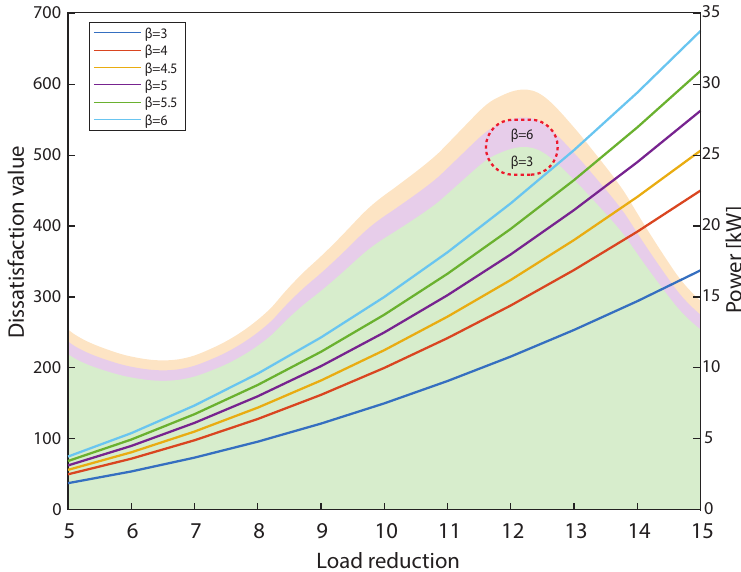
Figure 5. Unidirectional dissatisfaction value. However, within this approach, it is necessary to analyze not only the decrease in consumption but also the increase and its influence on consumer satisfaction; that is, a model that considers these two scenarios is necessary, for example, the above is shown in Figure 6. On the one hand, the model considers the scenario where a reduction in demand consumption represents a cost of dissatisfaction that increases when this decreases. On the other hand, it is considered when the consumers receive an economic incentive to increase their consumption, which reduces the cost of dissatisfaction.